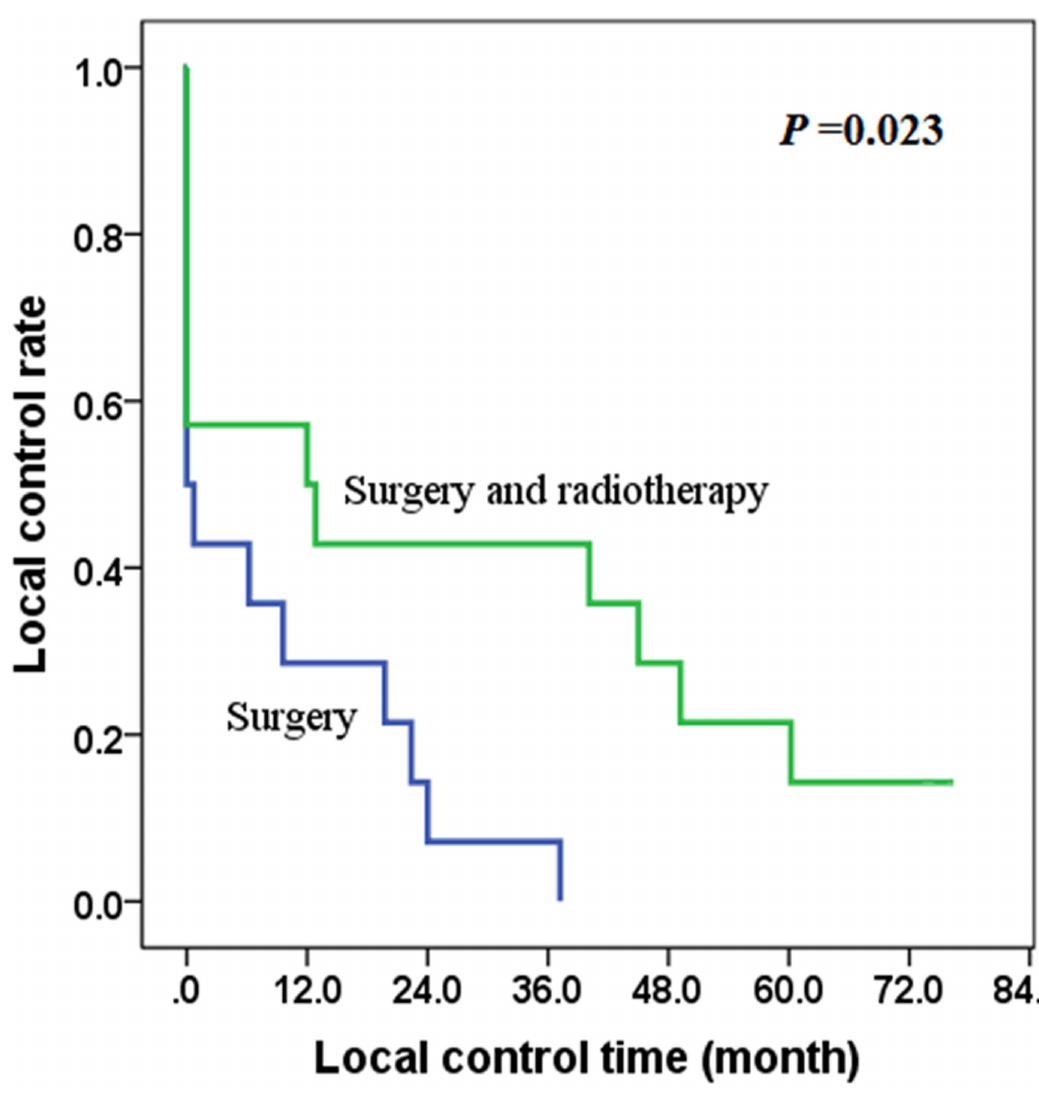
Fig 2. The effect of radiotherapy on local control of stage IVA and IVB